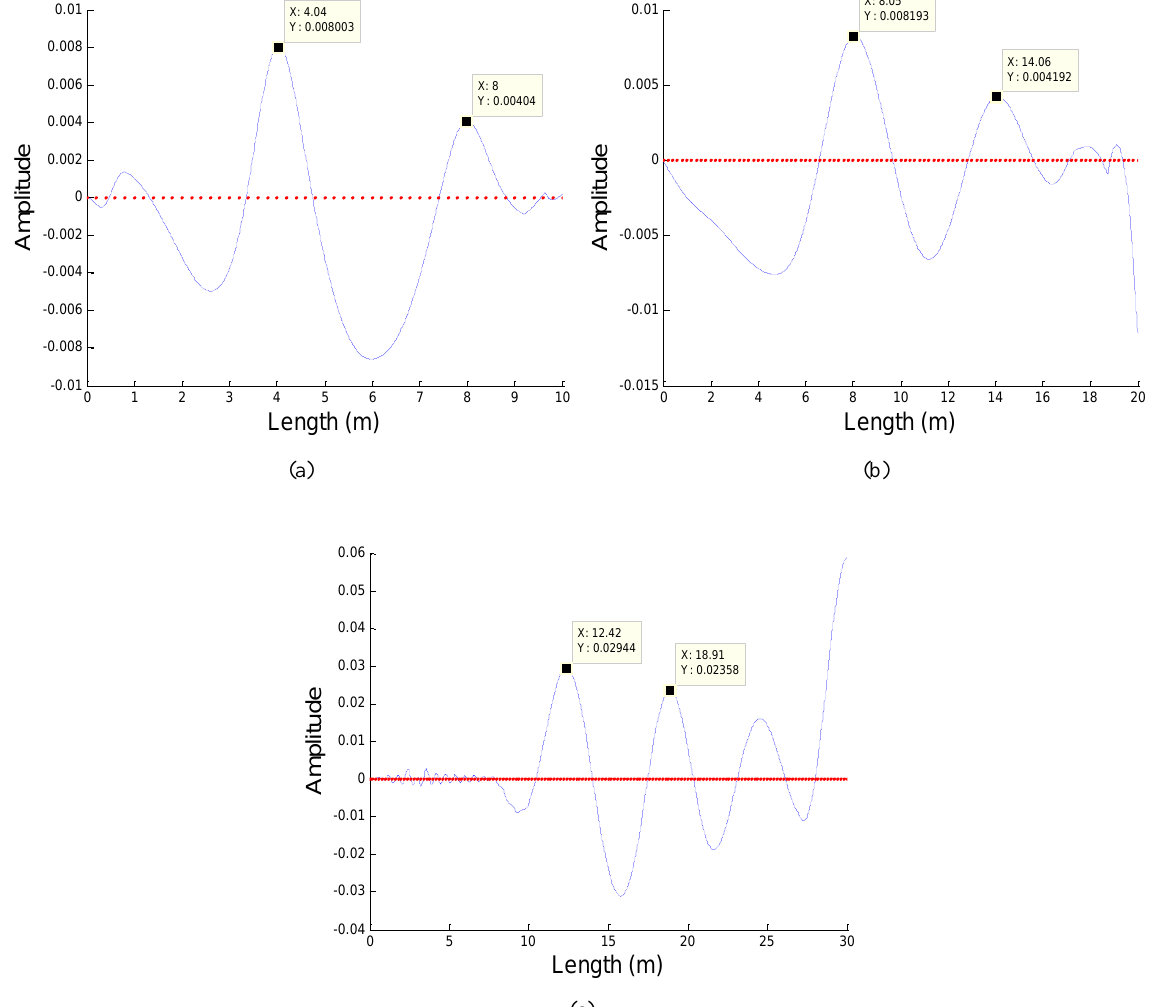
Fig. 7. IMF 1: (a) δ = 0.3 at 4 m and 8 m for a beam length of 10 m, (b) δ = 0.3 at 8 m and 14 m for a beam length of 20 m, (c) δ = 0.3 at 12 m and 19 m for a beam length of 30 m.